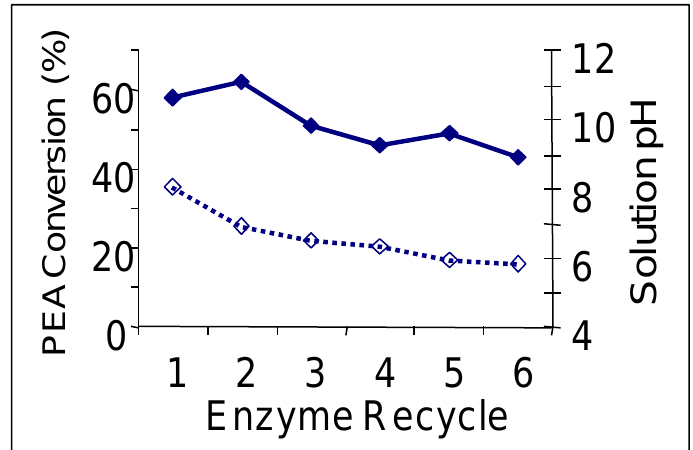
Figure 9. CAL B Recycles for Ester Hydrolysis in dioxane/H and measured solution pH )